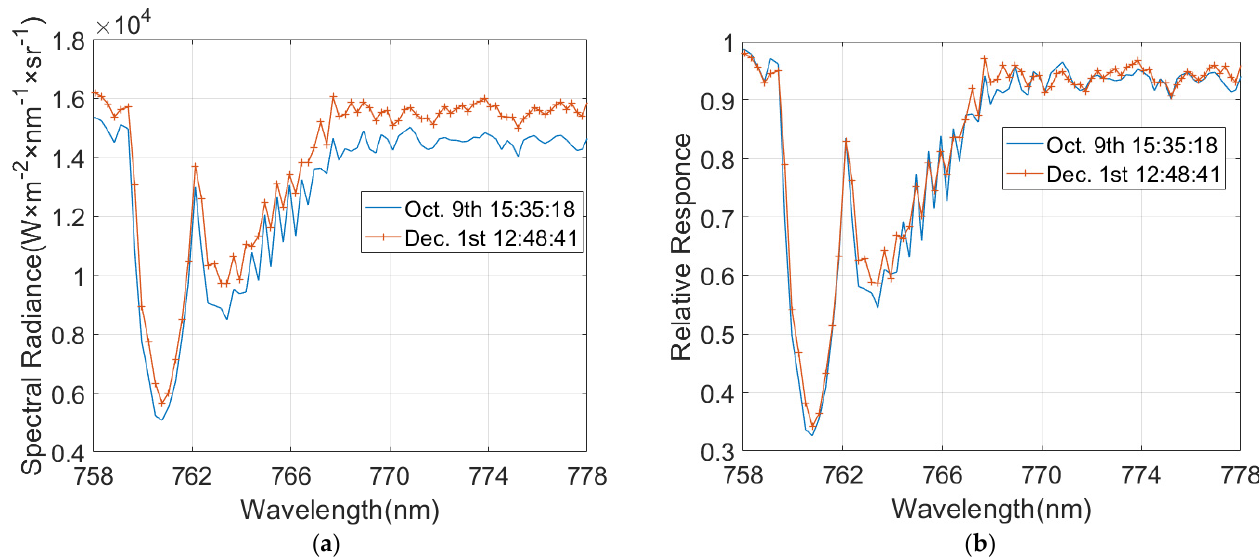
Figure 14. Spectral radiance data ( a ) and relative response ( b ) of HARIS obtained from the two observa-tions in October and December.